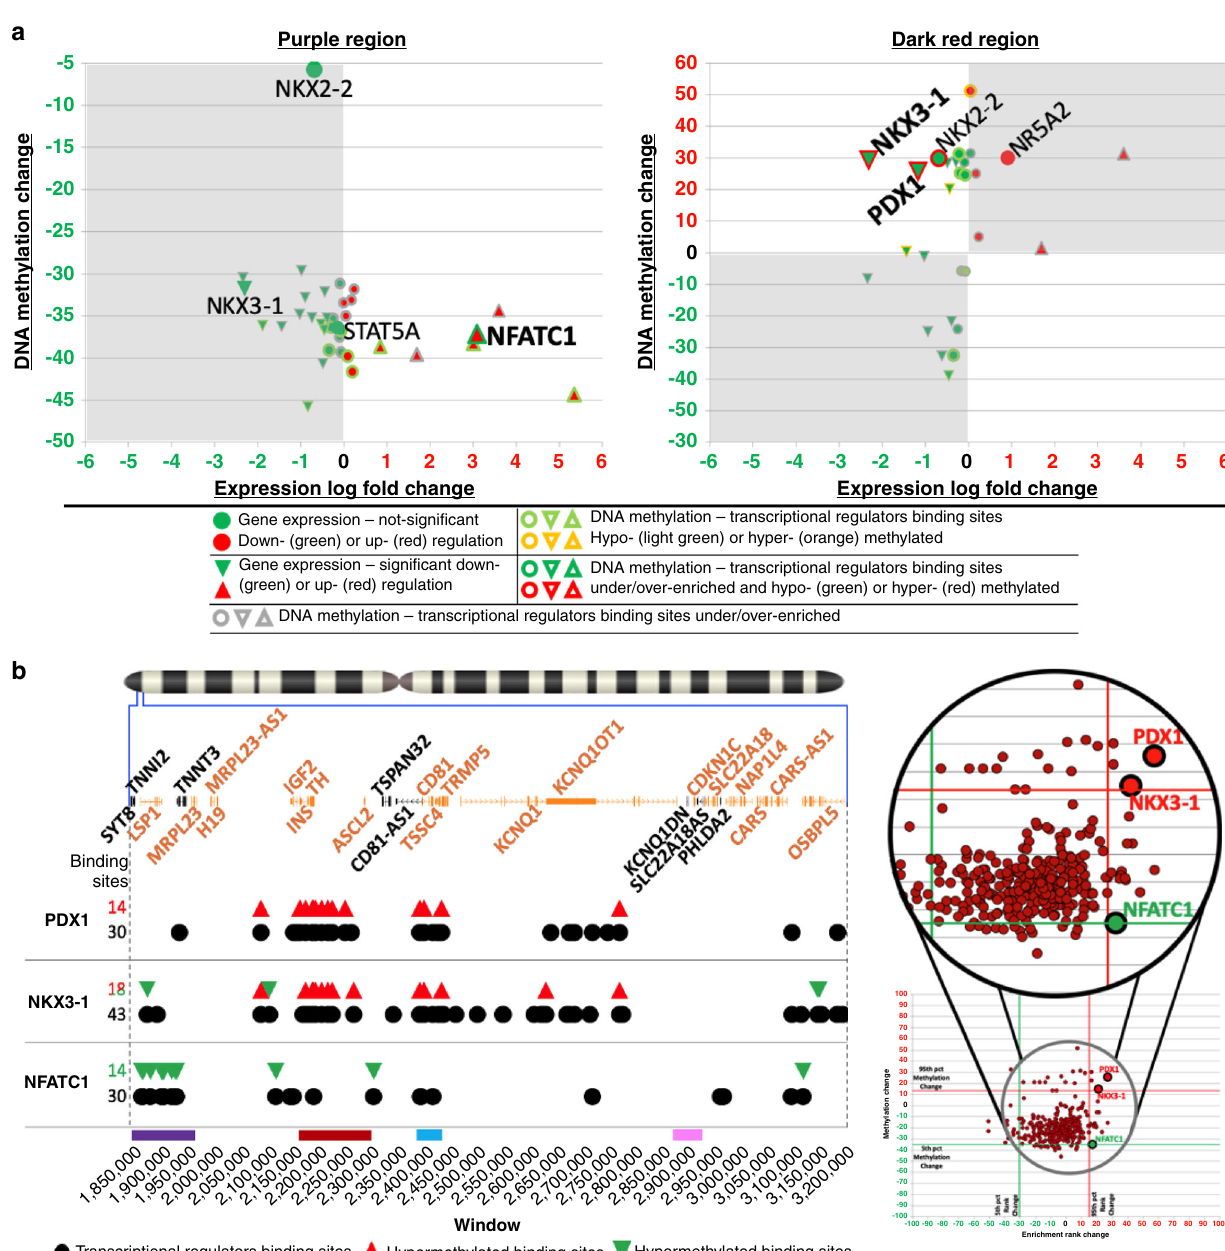
Fig. 5 Identifying the key transcriptional regulator binding sites in the purple and dark red regions. a Comparison of transcriptional regulator binding site DNA methylation vs. transcriptional regulator expression. For both graphs, the X axis reports the expression fold change 10 and the Y axis the cumulative methylation change between insulinomas and beta cells. Following the same approach as in Fig. 2a, for each transcriptional regulator, reduced binding site availability (hypermethylation) should be accompanied by a reduction in its expression. Conversely, increase binding site availability (hypomethylation) should overlap with increased expression. Thus, the portions of both graphs with discordant methylation and expression directions are shaded in gray. The transcriptional regulator binding sites that are differentially enriched/methylated (<5th ‰ and >95th ‰ ) are shown (see Supplementary Data 15 for details). Only transcriptional regulators NFATC1, in the purple region, and PDX1 and NKX3-1, in the dark red region, show concordant enrichment/methylation (<5th ‰ or >95th ‰ ) and signi fi cant expression dysregulation. b The chromosome 11 ideogram with a magni fi cation of the 11p15.5-p15.4 target sub-region is as described in Fig. 1a. Comparative distribution of all vs. the differentially methylated transcriptional regulator binding sites identi fi ed in a . The X axis provides a reference for the position of the transcriptional regulator binding sites across the target region. The Y axis represents the list of the transcriptional regulators from the dark red (PDX1, NKX3-1) and purple (NFATC1) regions. Each row illustrates the mapping of all binding sites for that transcriptional regulator (dark black circles) vs. differentially methylated (upward red triangle = hypermethylated; downward green triangle = hypomethylated) binding sites. PDX1 binding sites in the red region solely carry hypermethylated CpG dinucleotides and are presumably less accessible to the binding of the PDX1 transcription factor. NKX3-1 sites reveal a mixed pro fi le that correlates only moderately with its signi fi cantly downregulated expression. NFATC1 binding sites solely carry hypomethylated CpG dinucleotides and are thus presumably available for NFaT binding (Supplementary Data 17). The panel on the right is adapted from Fig. 3c and highlights the methylation/enrichment of PDX1, NKX3-1, and NFATC1 binding sites in Fig.